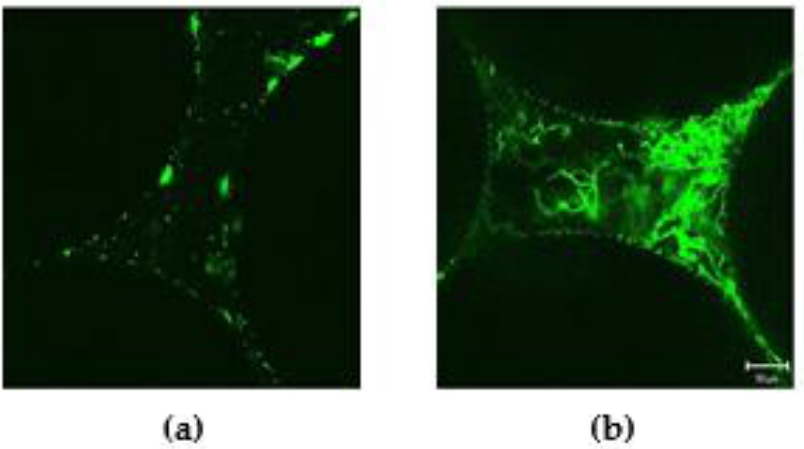
Figure 5. Gray-scale CLSM images for biofilm structures formed under different Darcy velocities: ( a ) q = 1.25 mm/min; ( b ) q = 7.5 mm/min (reproduced with permission from [62], Copyright Water Research , 2010). The dark areas represent the glass beads and pore space, the green color indicates stained biomass (bacteria and EPS) attached on the glass bead surfaces.